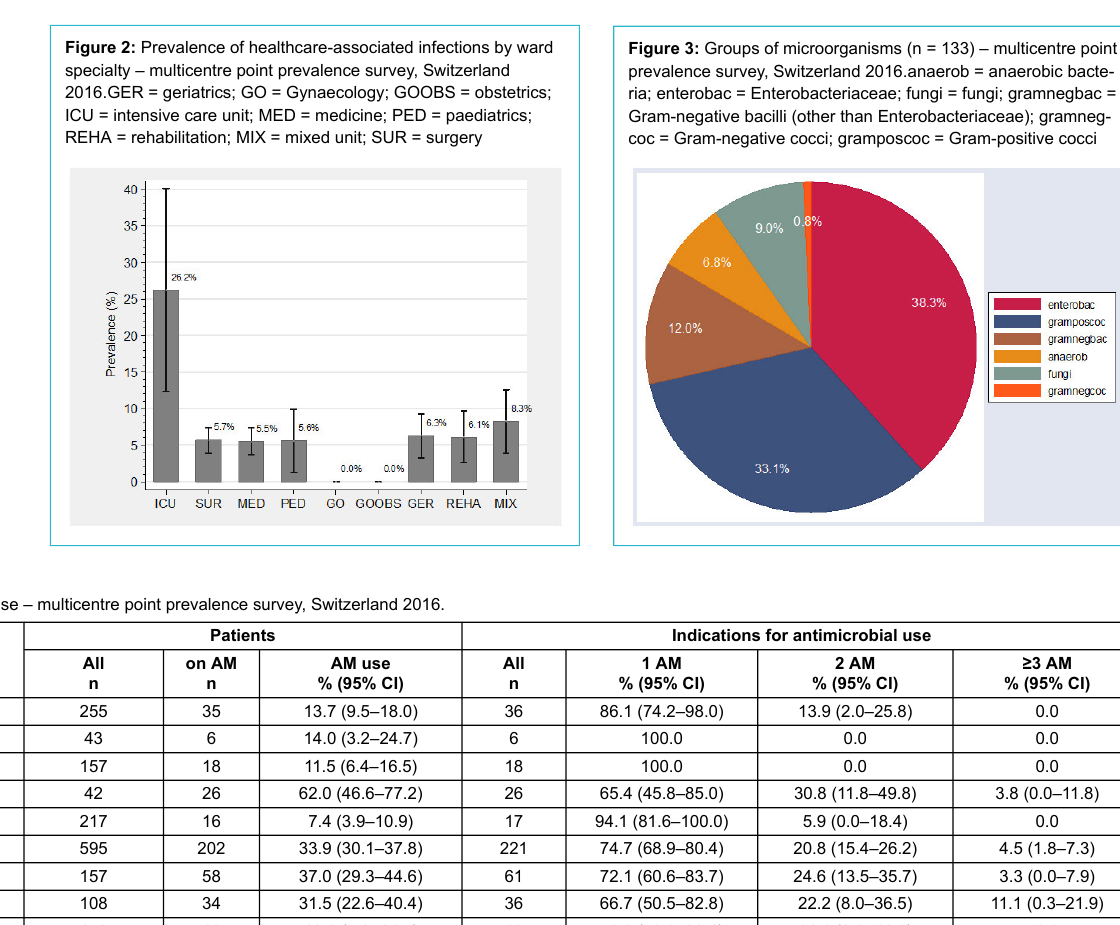
use of antimicrobial groups by ward specialty, revealing beta-lactam antibiotics to be the largest group of antimicro- bials prescribed in the majority of ward specialties. Figure 3: Groups of microorganisms (n = 133) – multicentre point prevalence survey, Switzerland 2016.anaerob = anaerobic bacte- ria; enterobac = Enterobacteriaceae; fungi = fungi; gramnegbac = Gram-negative bacilli (other than Enterobacteriaceae); gramneg-